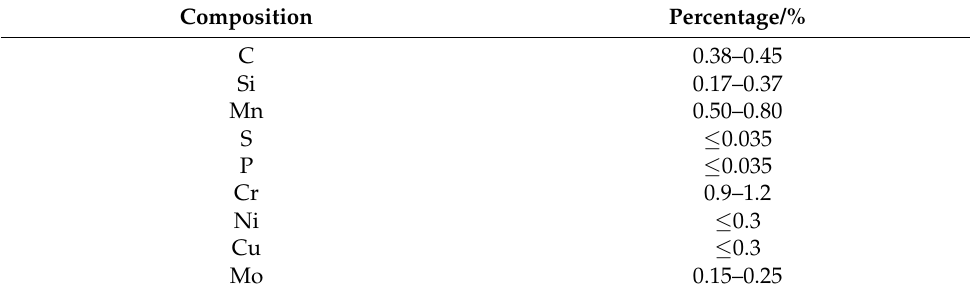
Table 1. The main components of the